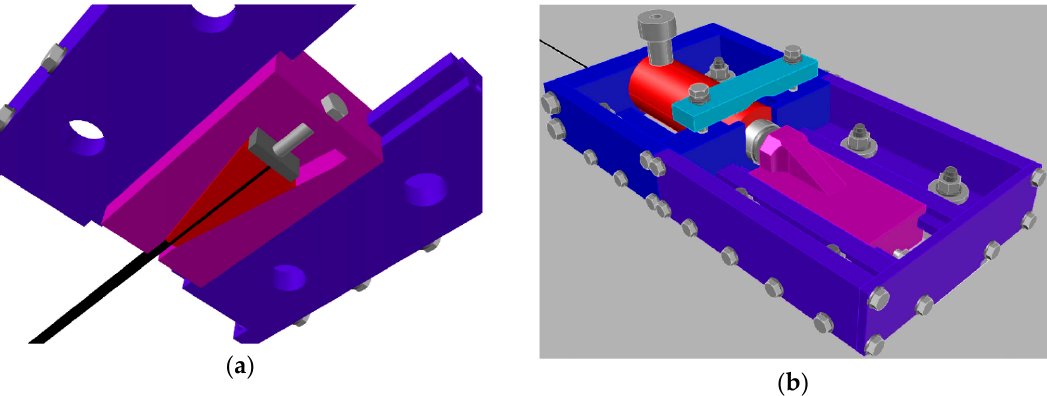
Figure 3. NSM pretensioning system for CFRP strips: ( a ) top view (against the beam soffit); and ( b ) bottom view.